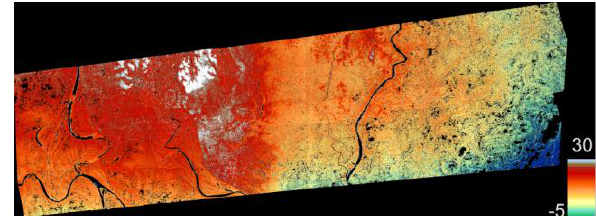
Figure 14. Original CORONA DSM based on correction grid